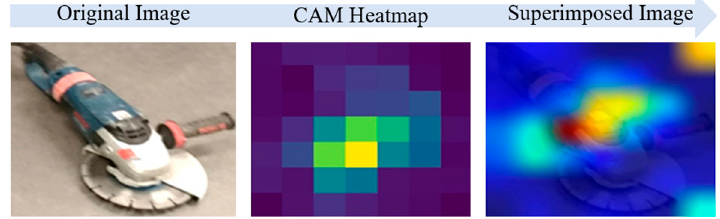
Figure 6. Visualization of Grad-CAM heatmap and the superimposed image.